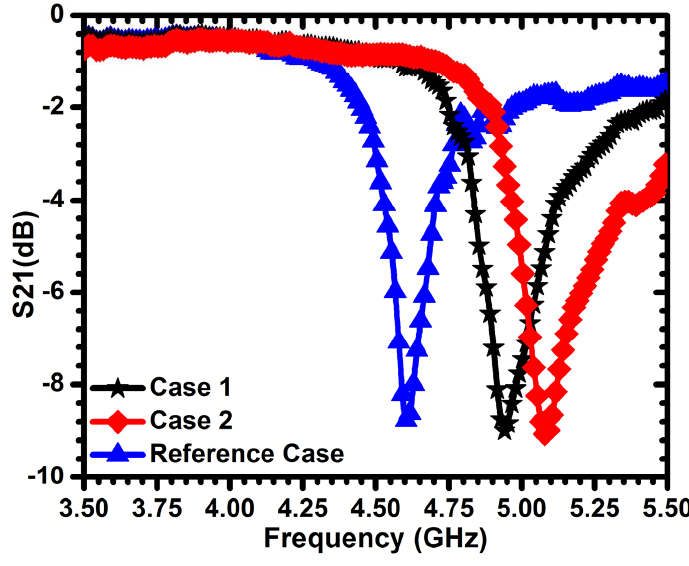
Figure 20. Minimum transmission of the sensor for a crack width (w) of 150 µ m (Case 1) and 200 µ m (Case 2) compared with a solid dielectric material, ceramic (ceramic material), with a dielectric constant of 9.8 (reference case). The crack depth (h) is 1 . 5